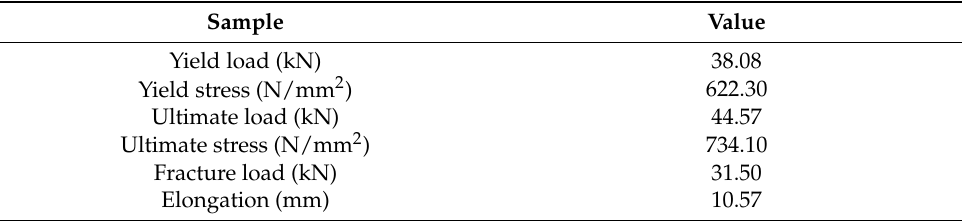
Table 1. Tensile strength for high strength steel bar with diameter of 10 mm.